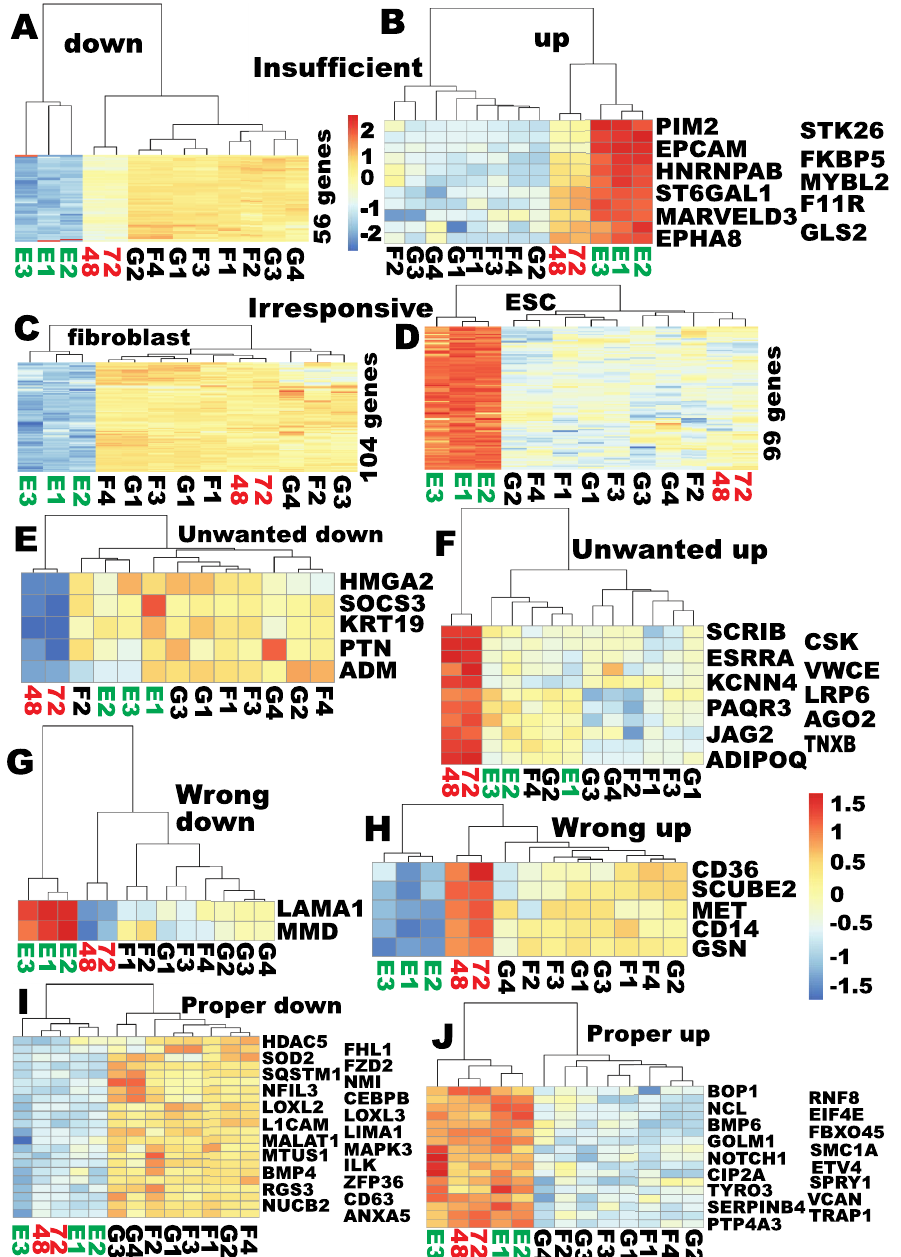
Figure 6. A Proper, Insufficient, Aberrant, and NO reprogramming (PIANO) response of the annotated MET genes to OSKM reprogramming at the time of proper RB reprogramming. ( A ) insufficient downreprogramming (56 genes); ( B ) insufficient upreprogramming (11 genes); ( C ) 104 fibroblast-enriched genes were irresponsive to OSKM reprogramming; ( D ) 99 hPSC-enriched genes were irresponsive to OSKM reprogramming; ( E ) 5 common MET genes were downregulated when they should have not been; ( F ) 11 common MET genes were upregulated when they should have not been; ( G ) 2 MET genes were wrongly downregulated when they should have been upreprogrammed; ( H ) 5 MET genes were wrongly upregulated when they should have been downreprogrammed; ( I ) 22 fibroblast-enriched genes were properly downreprogrammed; ( J ) 17 hPSC-enriched genes were properly upreprogrammed. Color scales of read counts are the same as shown by heat map ( A ), except for ( B ), ( G ), and ( H ) that share the second color scales as shown by ( H ). See also Supplementary Figure